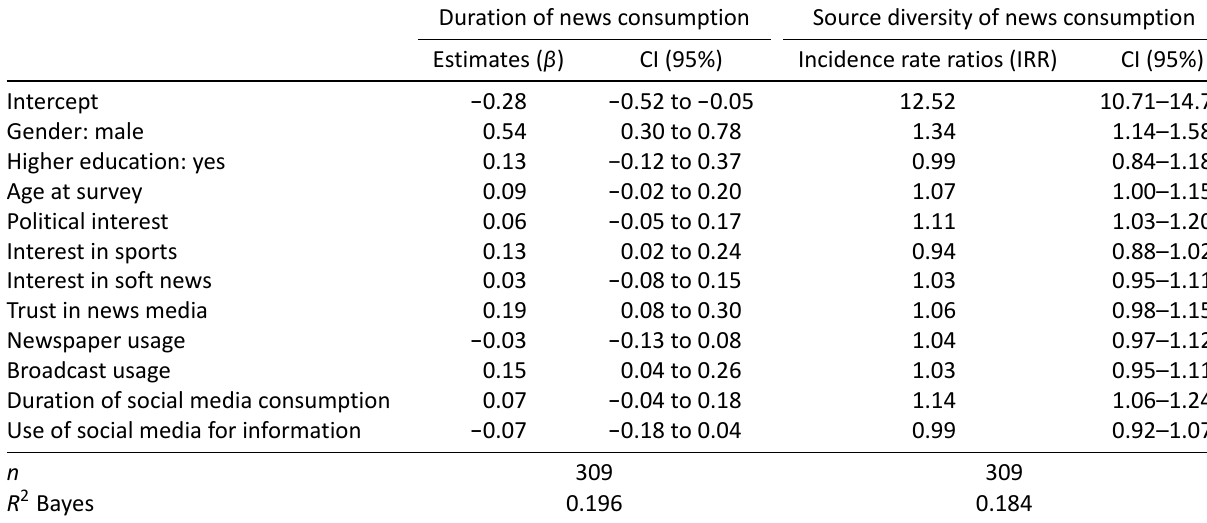
Table 1. Regression models for the duration and source diversity of news consumption.